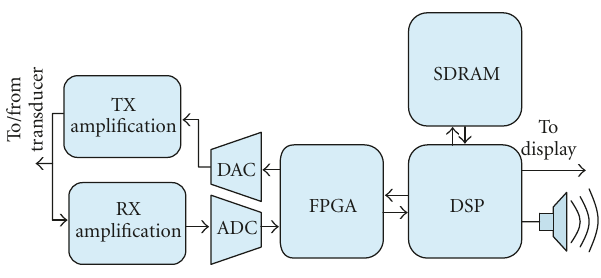
Figure 2: MCMG digital